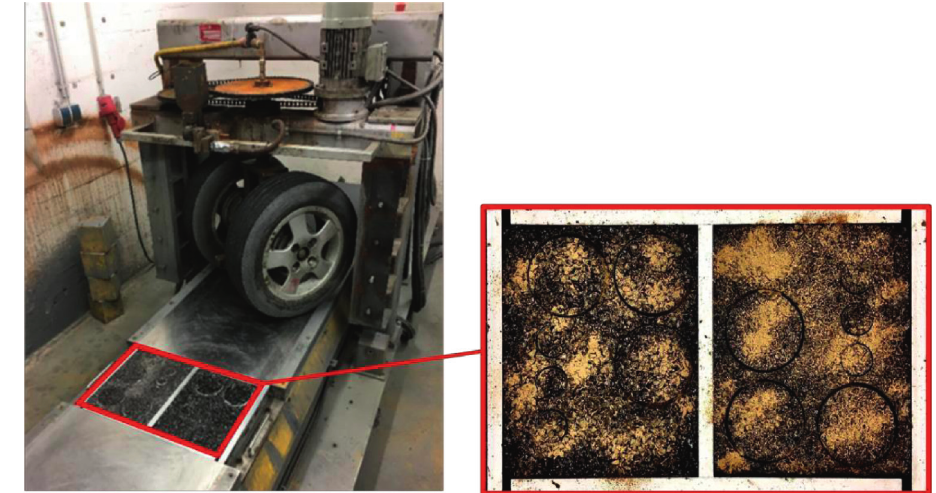
Figure 3: Clogging simulated by Aachen Polishing Machine